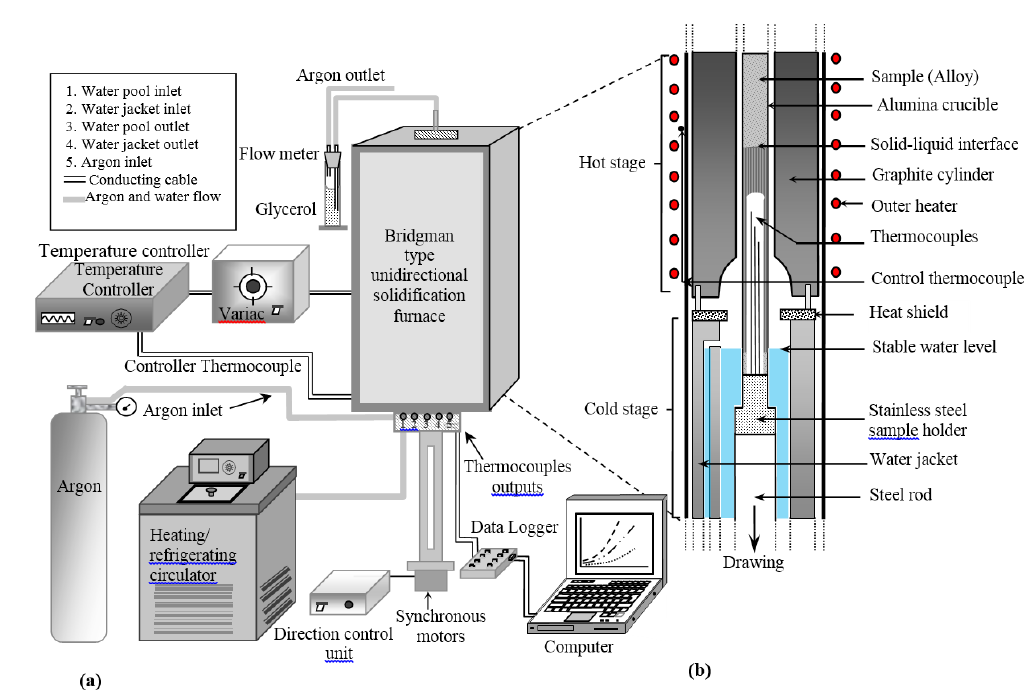
Figure 2. (a) Block diagram of the experimental setup, (b) The details of the Bridgman–type directional solidification